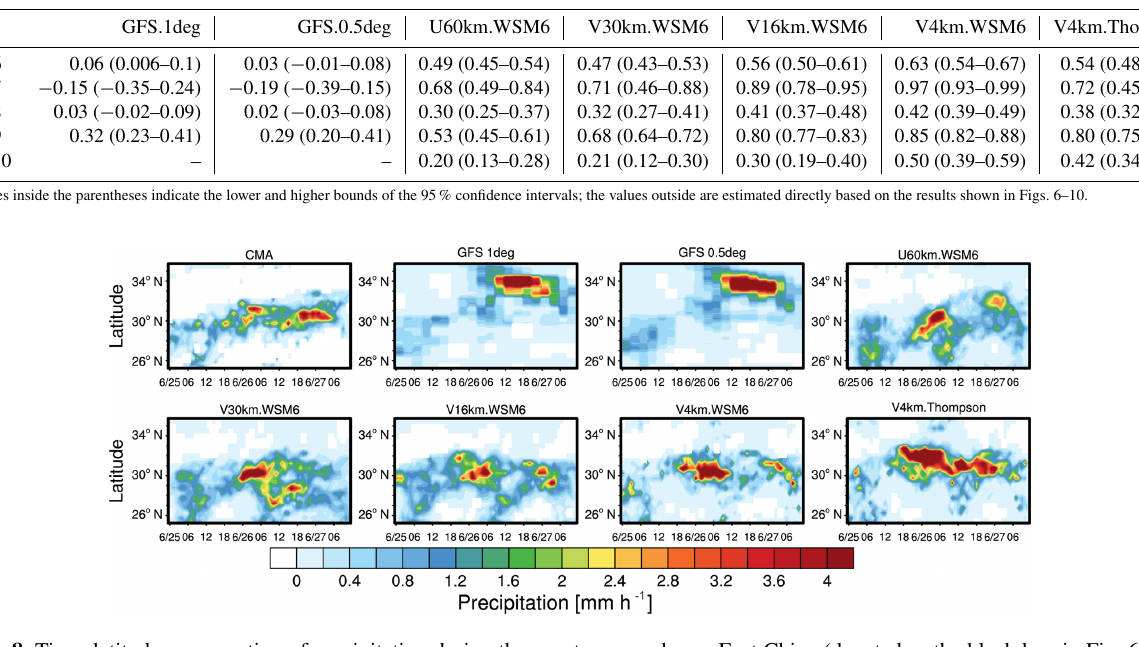
Figure 8. Time–latitude cross section of precipitation during the event averaged over East China (denoted as the black box in Fig. 6) from the CMA station observations, GFS forecasts at 0.5 and 1.0 ◦ resolutions, and the MPAS simulations at resolutions of 60, 30, 16, and 4km. The simulations at 4km are with two cloud microphysics schemes (WSM6 and Thompson). The modeling results are sampled at the CMA